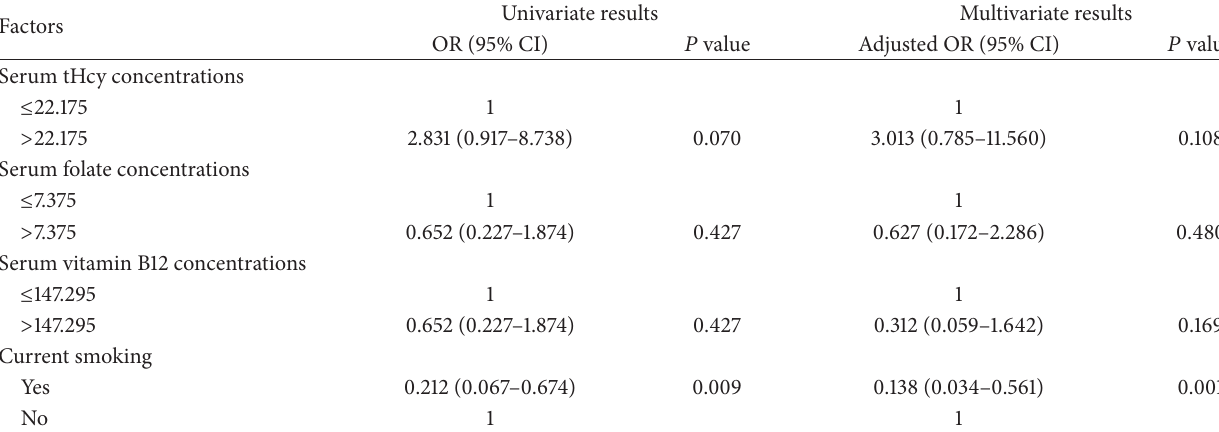
Table 4: Univariate and multivariate analysis for the association between PD and possible risk